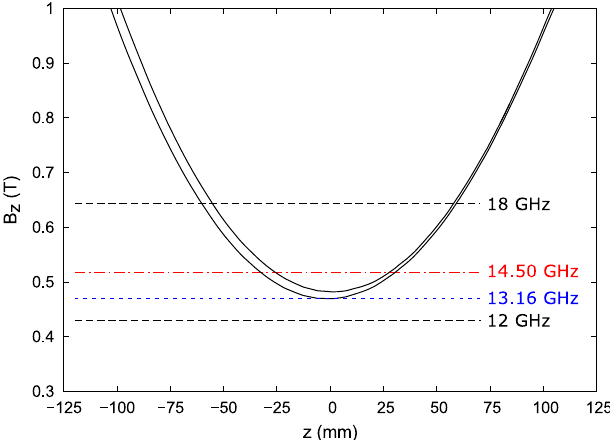
FIG. 14. The GTS-LHC magnetic field profile on axis around the minimum B field and resonance fields for nonrelativistic electrons at selected frequencies. The magnetic fields resulting from the different solenoid settings used in the experiments fall within the presented field